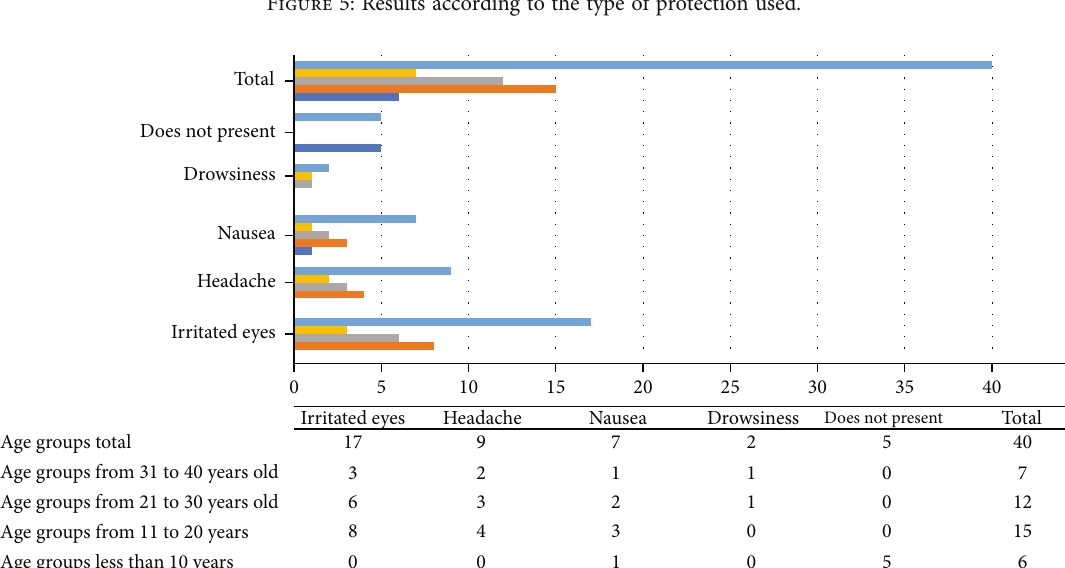
Figure 5: Results according to the type of protection used.